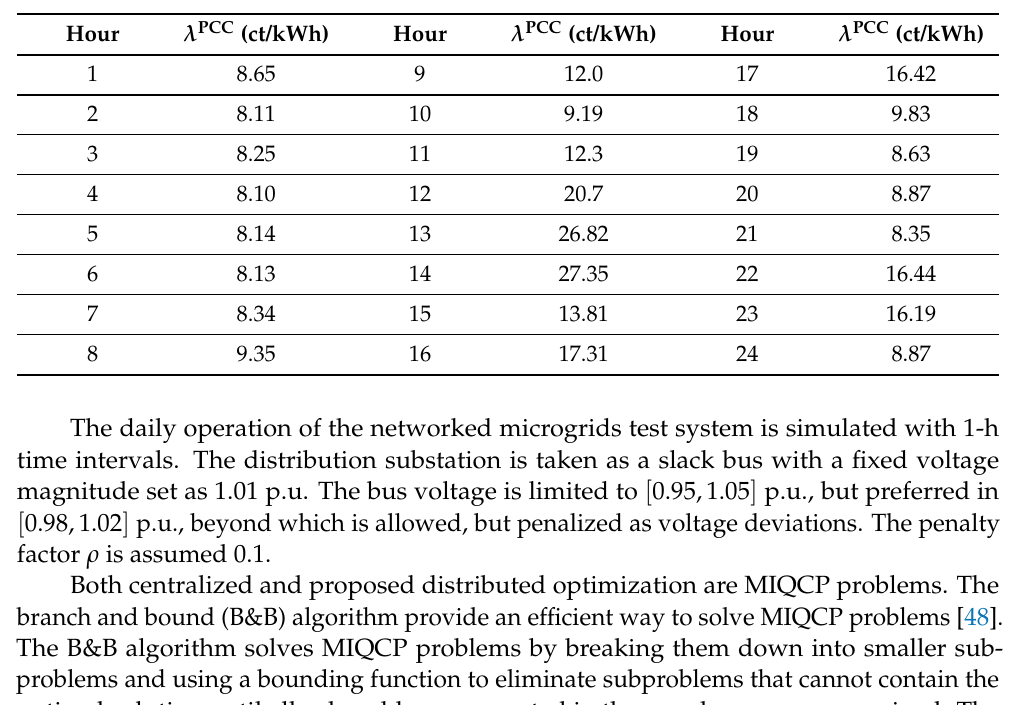
Table 4. Utility